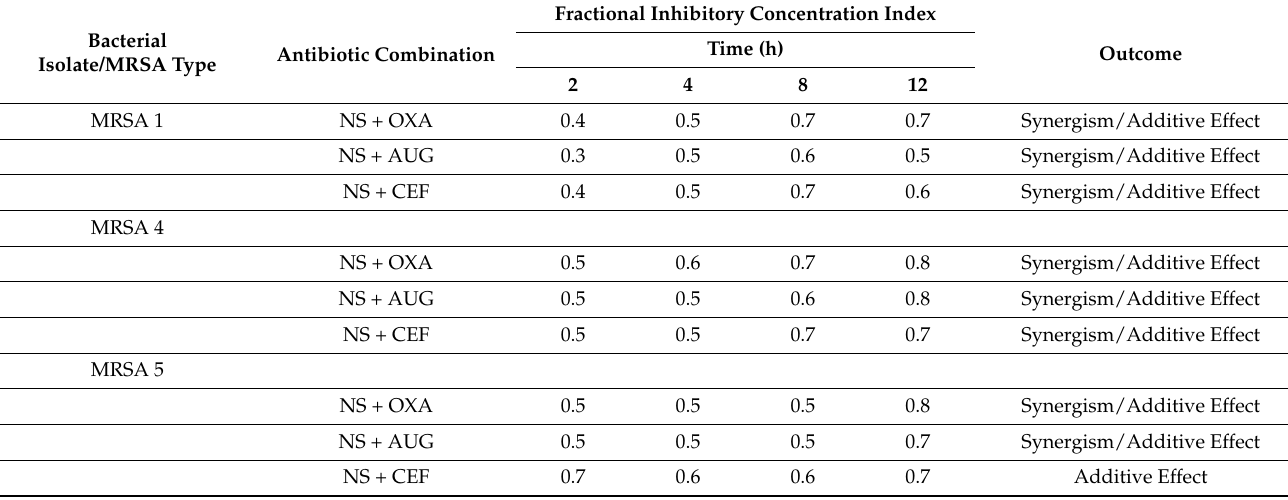
Table 2. Fractional inhibitory concentration index synergy interpretation of different MRSA isolates measured at time intervals for combinations of 5.0 µ g/mL N. sativa and